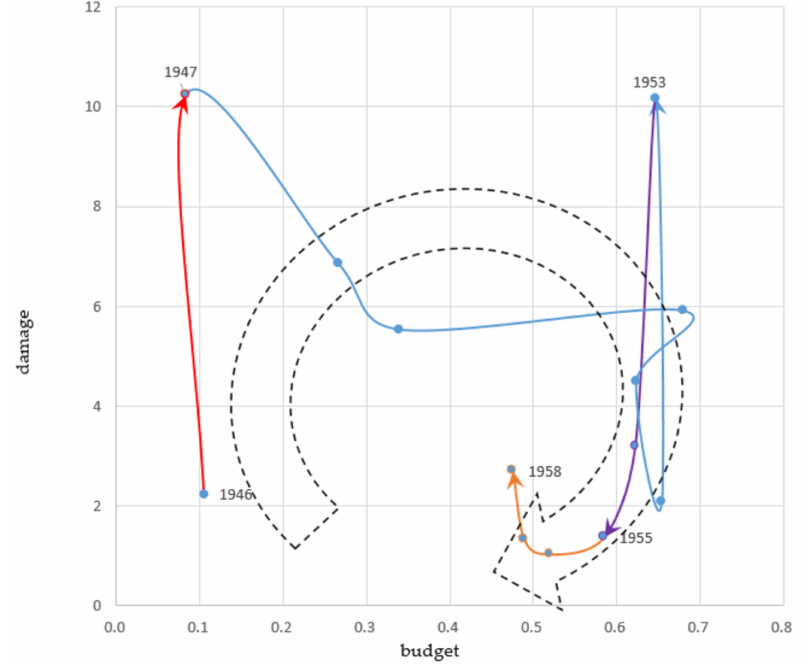
Figure 5. Fourth investment cycle 1945–1958 (Share of the National Income %). Source: Authors’